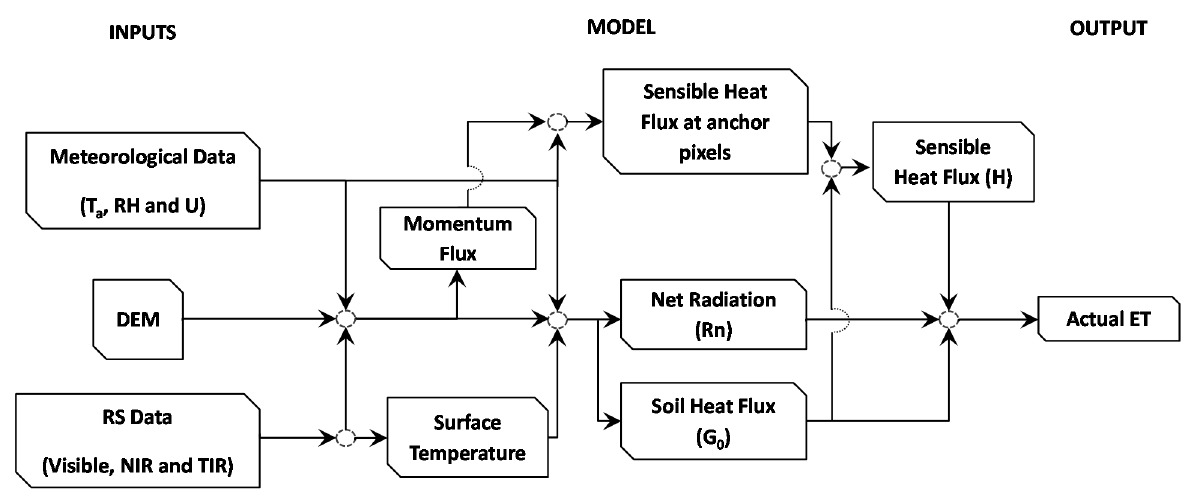
Figure 2. Flowchart of SEBAL model, main inputs, and output. (U is the wind speed, RH is the relative humidity and Ta is air temperature).